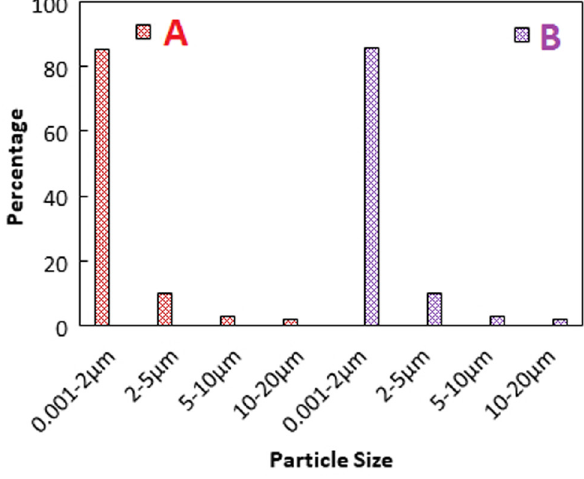
Figure 3: Particle size distribution of the catalysts particles: (A) , (b) Ag-TiO . TiO , (B) Ag-TiO 2 2 2 2